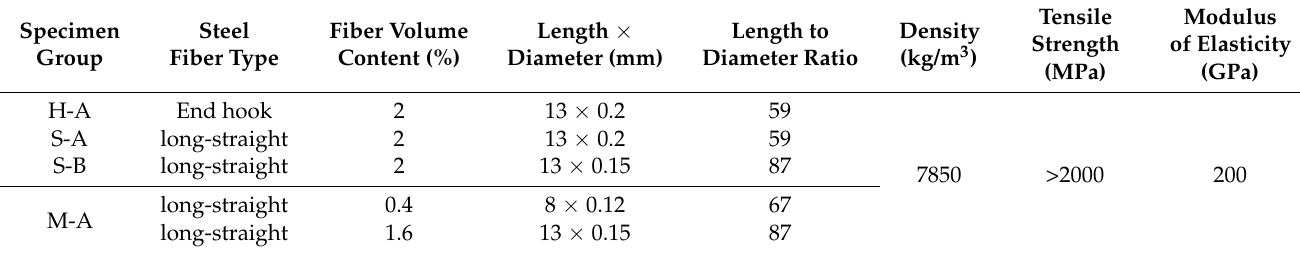
Table 2. The characteristics of the RPC–steel fiber of the tensile test.